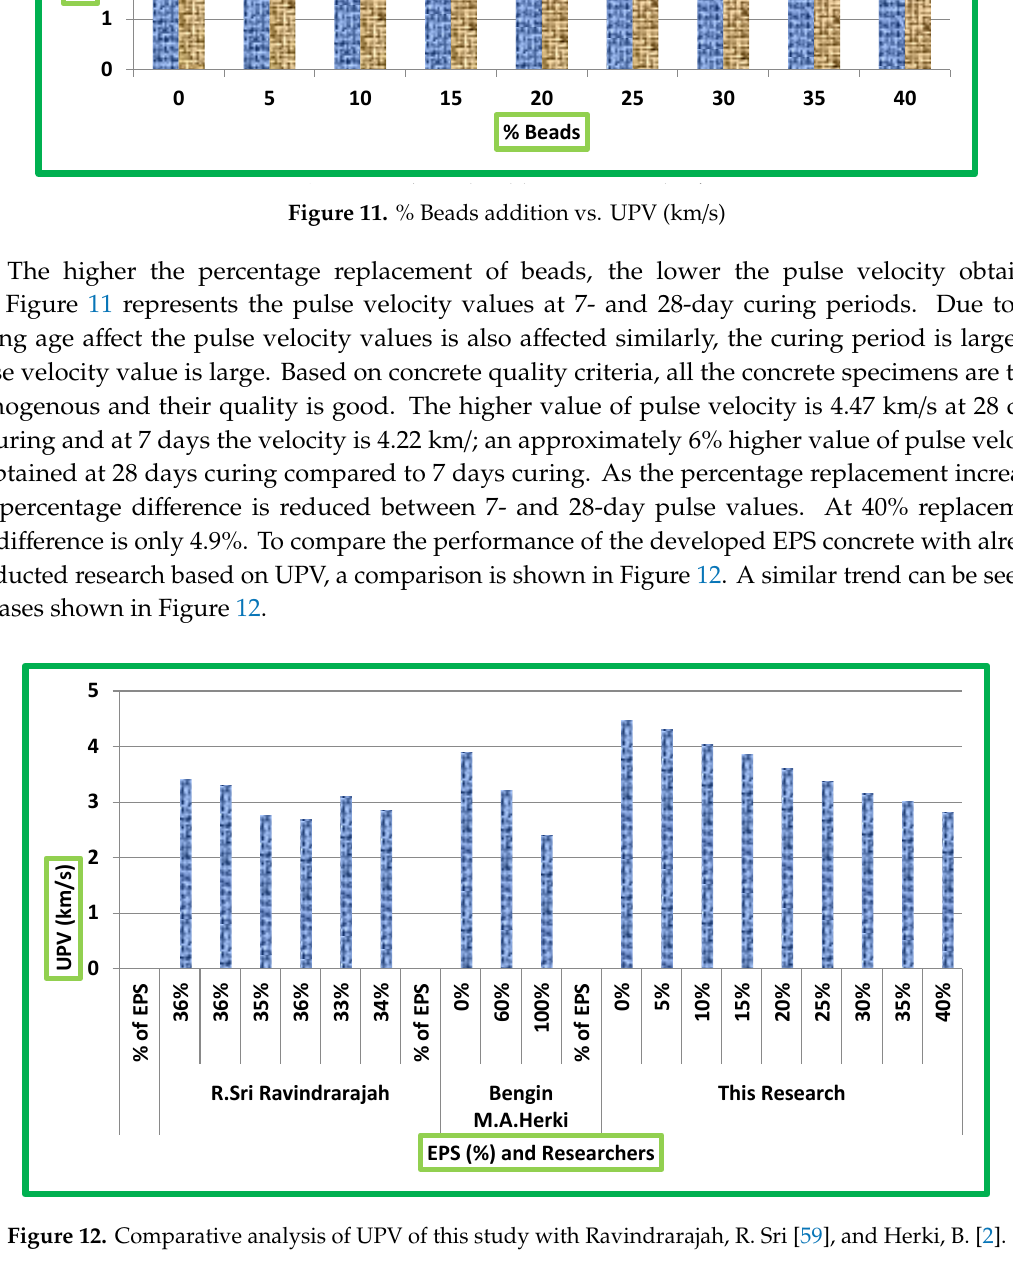
Figure 12. Comparative analysis of UPV of this study with Ravindrarajah, R. Sri [59], and Herki, B.[2].